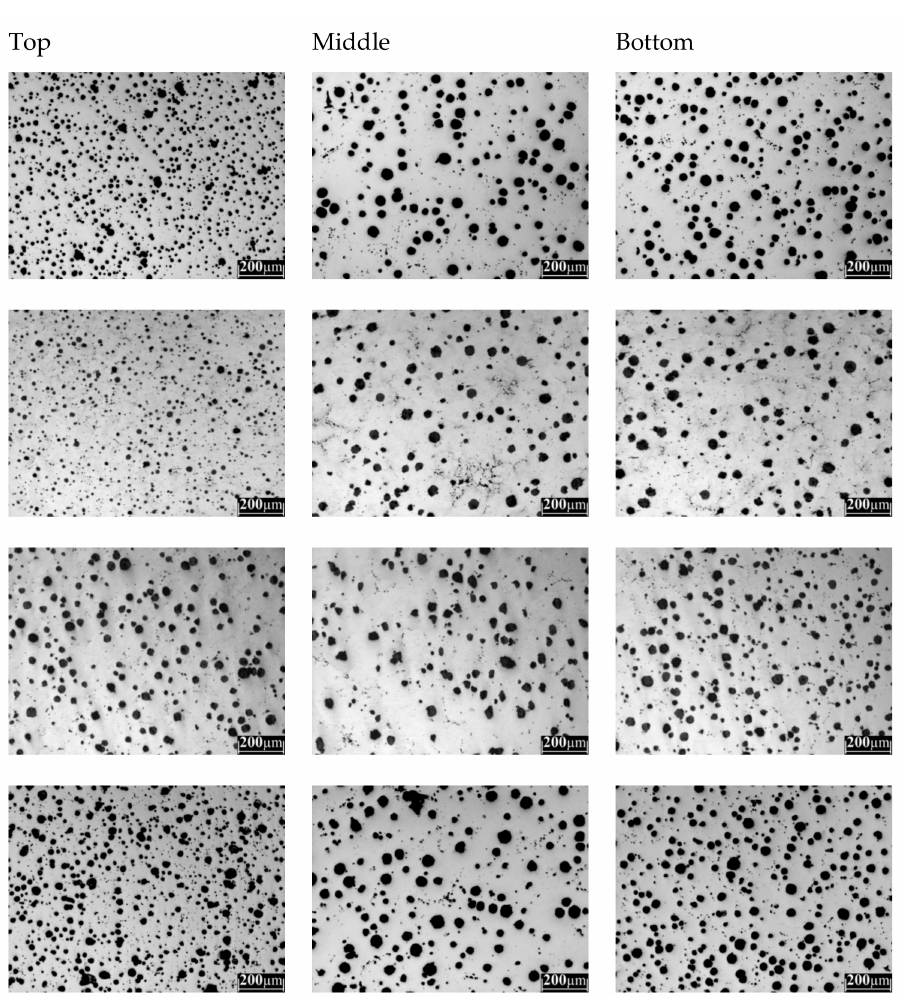
Figure A1. Unetched microstructure of the ductile iron alloyed with 0.2 wt % V for different lobes and regions.